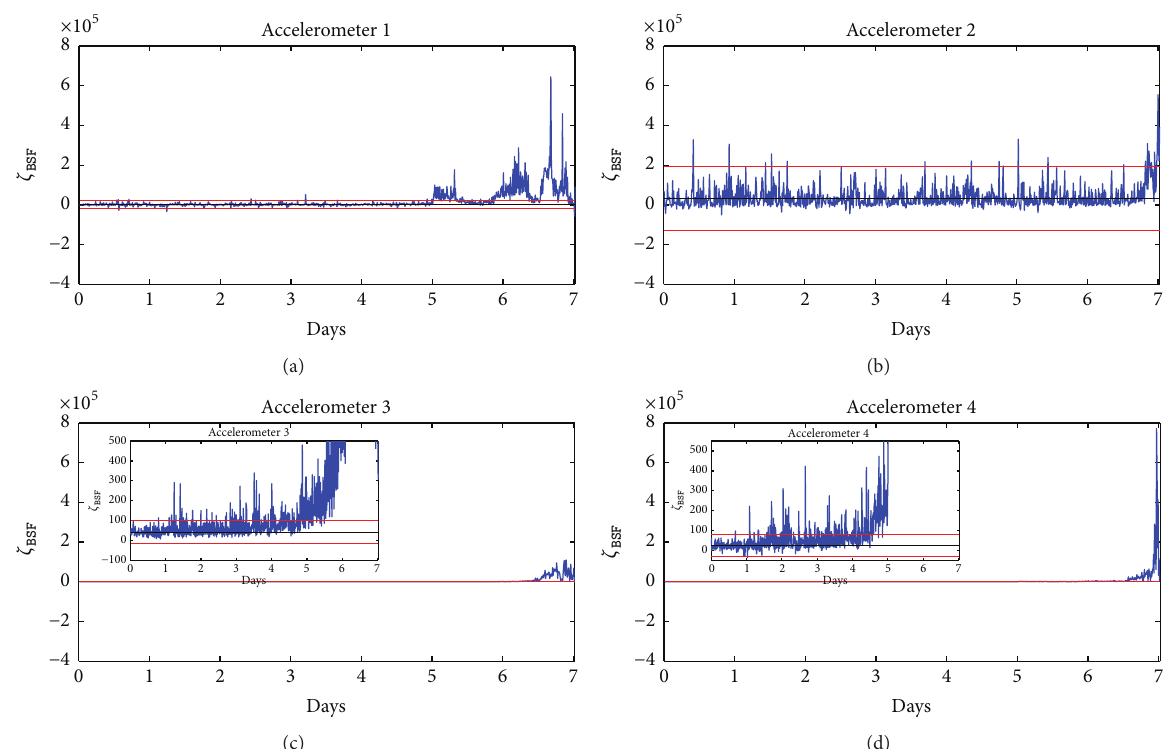
Figure 9: Damage indicators associated with the BSF frequency from each